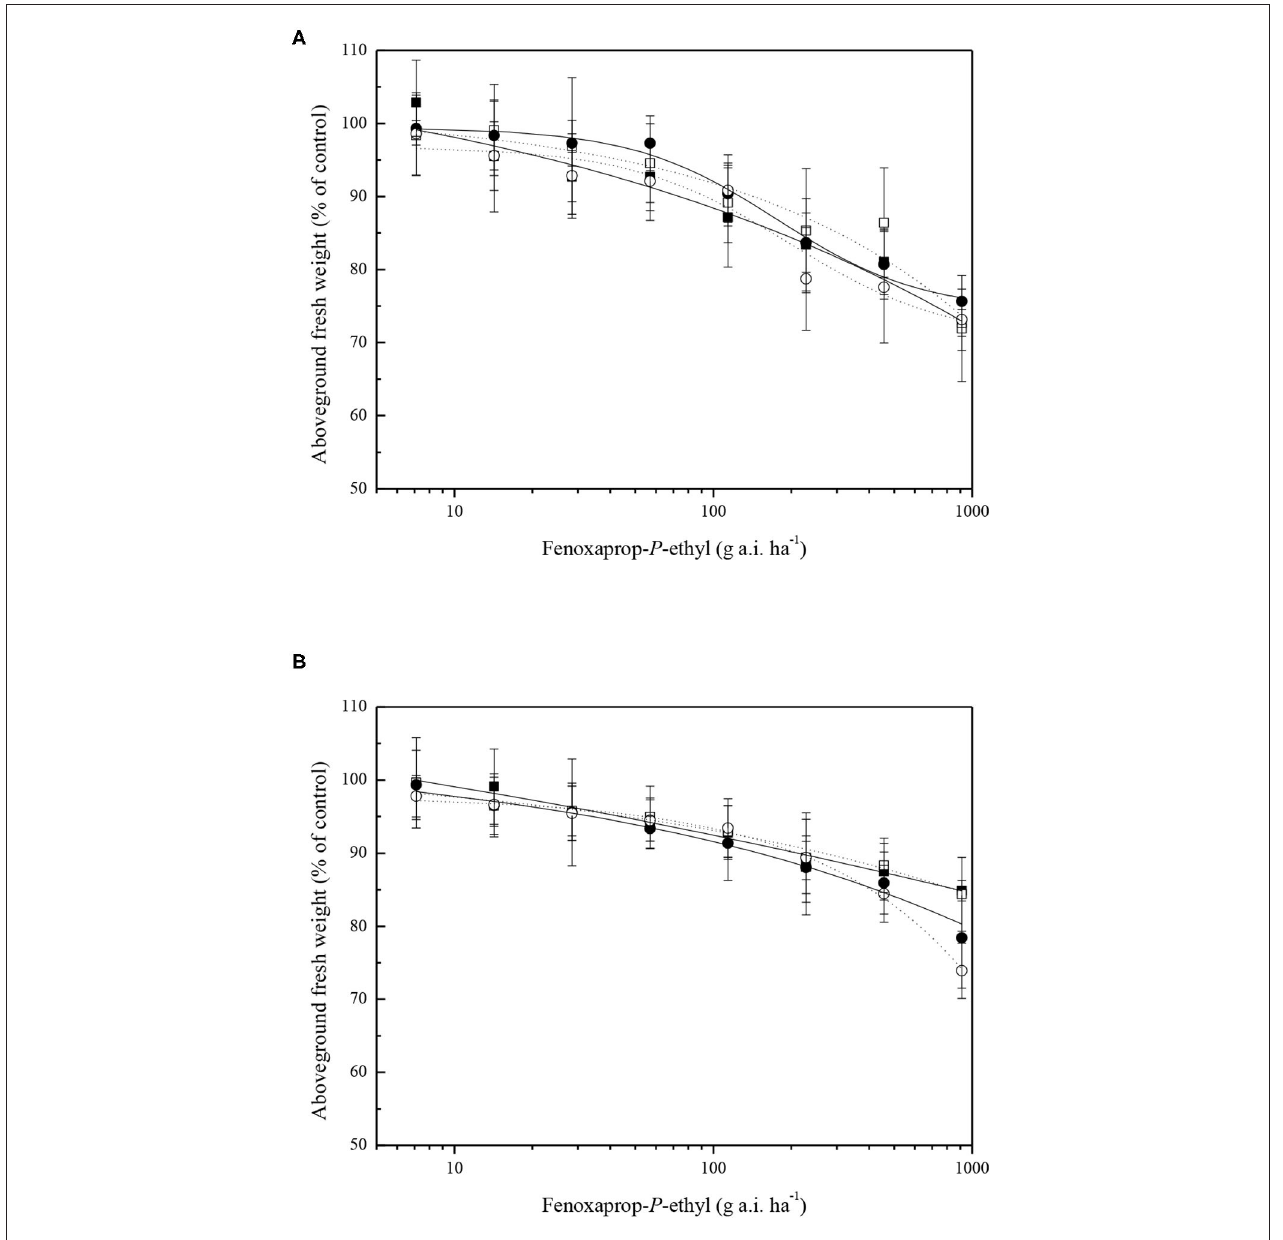
FIGURE 2 | Dose–response curves for fresh weight reduction of two common roegneria populations (ZJJX, (cid:4) or (cid:3) ) and (ZJHZ, • or ◦ ) treated with a range of fenoxaprop- P -ethyl doses plus (filled symbols) or minus (open symbols) 1,000g ha − 1 of malathion (A) and 80g ha − 1 NBD-Cl (B) . Vertical bars represent mean ± SE.